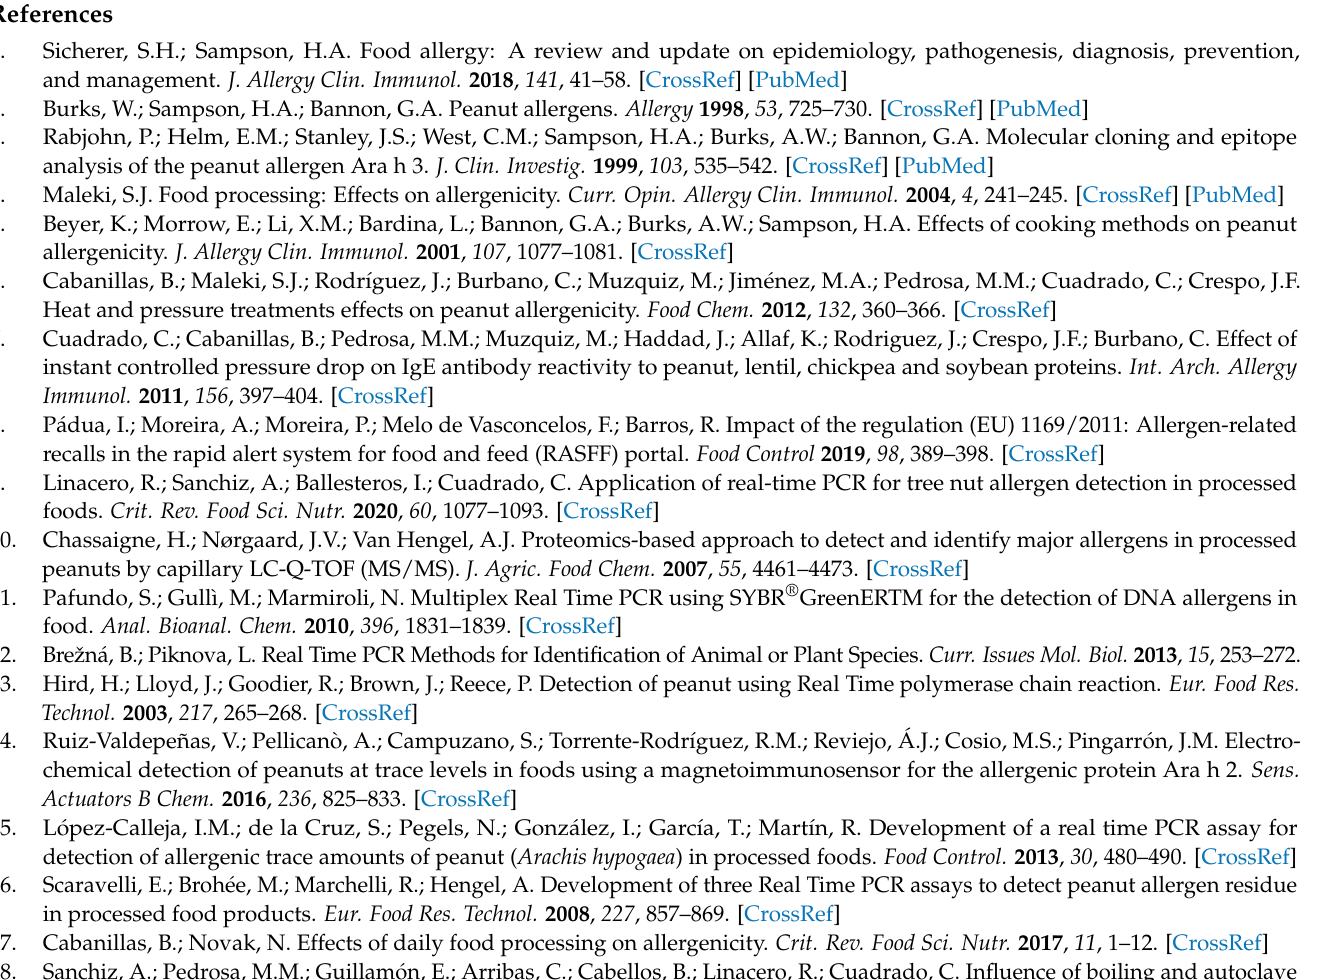
peanut in spelt wheat flours, Table S2: Primers used for sequencing purposes; Table S3: Detection of Figure S1: Sequence alignment of two clones of partial Ara h 6-allergen coding gene. Figure S2: flow chart summarizing protocols, procedures, markers, and the main findings of this